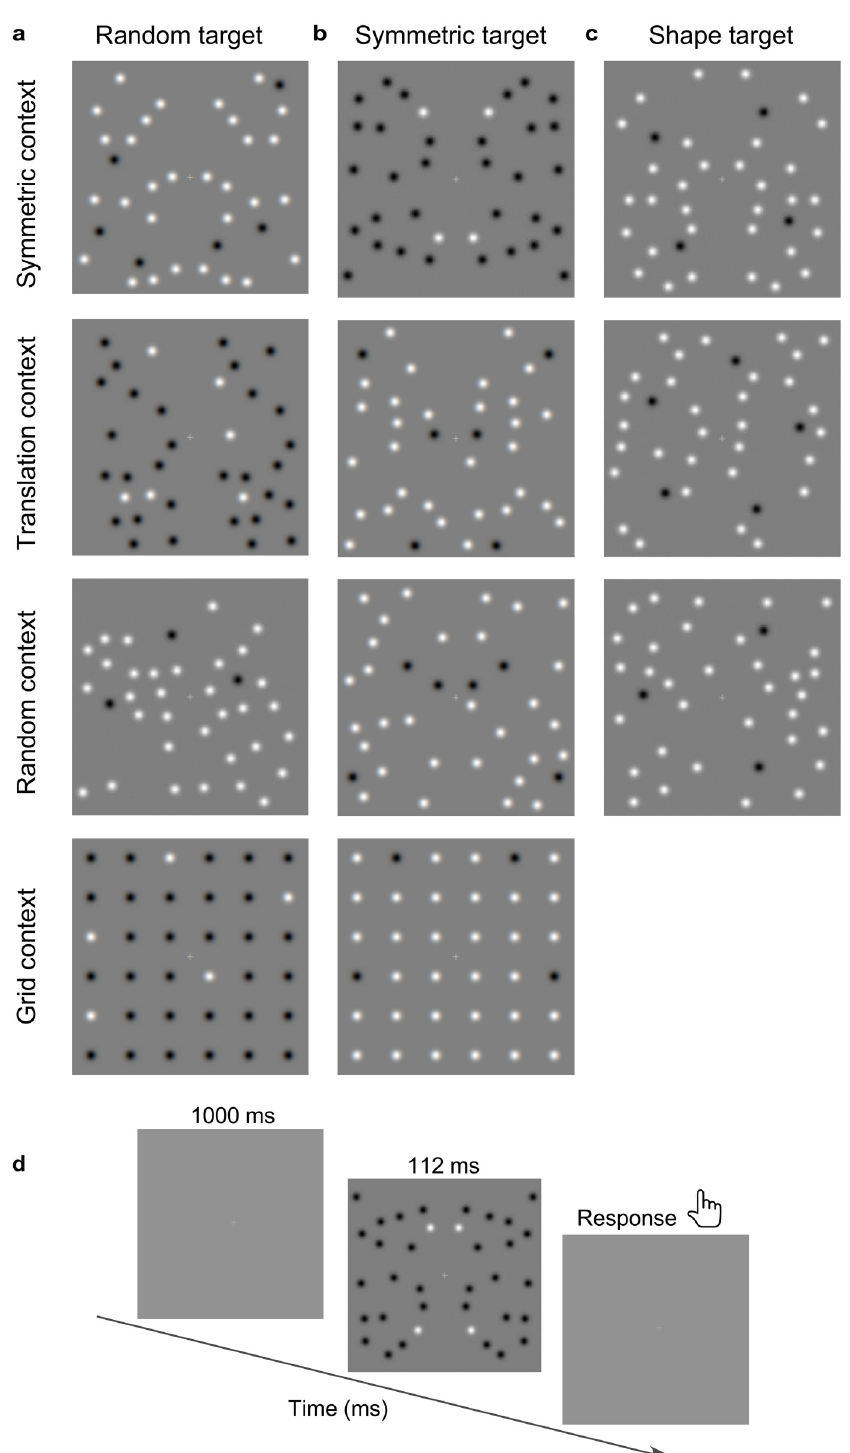
Fig 2. Experiment 4 stimuli. Achromatic dot patterns made of 36 elements that were divided into target (either 3, 4, 5 or 6) and context elements. The target elements were placed either (a) random, (b) mirror symmetric, or (c) on the vertices of simple geometric shapes (equilateral triangle, square, pentagons, hexagon). Context elements were organised either mirror symmetric (top), translation symmetric (2 nd row), randomly (3 rd row) and in a regular grid (bottom). Note that the combination of shape target—grid context was not used as placing target elements on the vertices of simple shapes (triangle, pentagon, hexagon) within a grid would break the regularity of the grid pattern. (d) Schematic representation of the